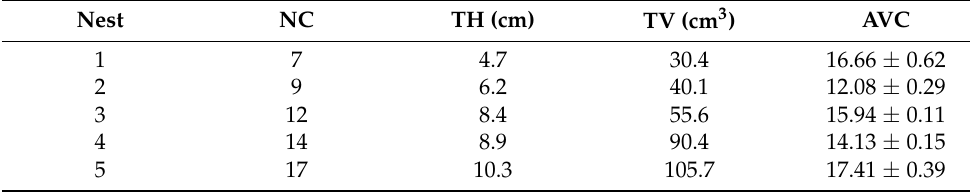
Table 3. Mean measurements ( ± standard error), for the number of chambers (NCs), total height